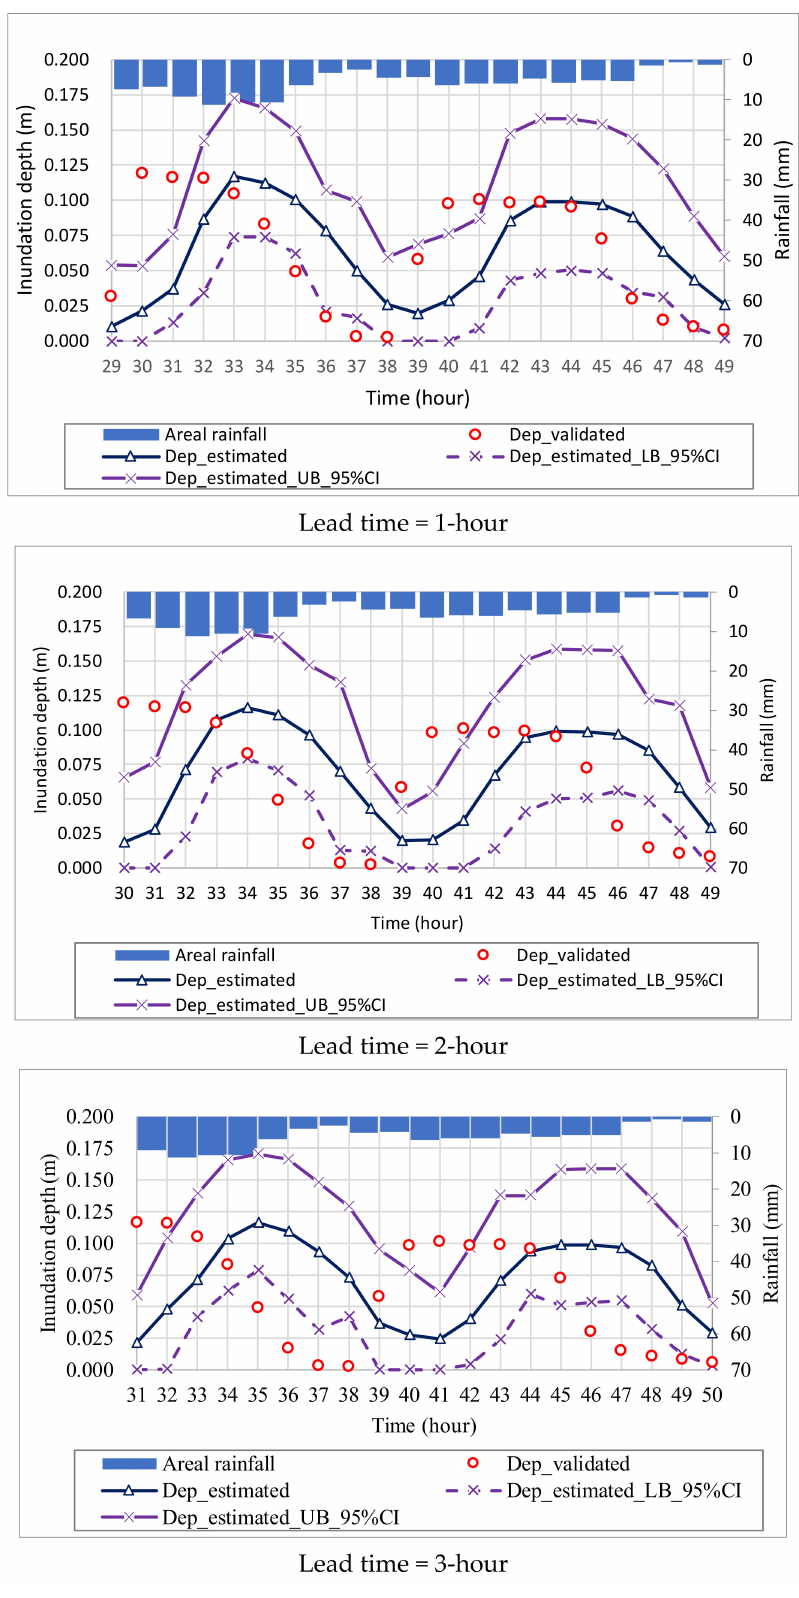
Figure 14. Comparison among the validated, estimated, and corrected inundation depths as well as the quantified 95% confidence intervals for the validated rainfall-induced flood event by the proposed SM_EID_IOT